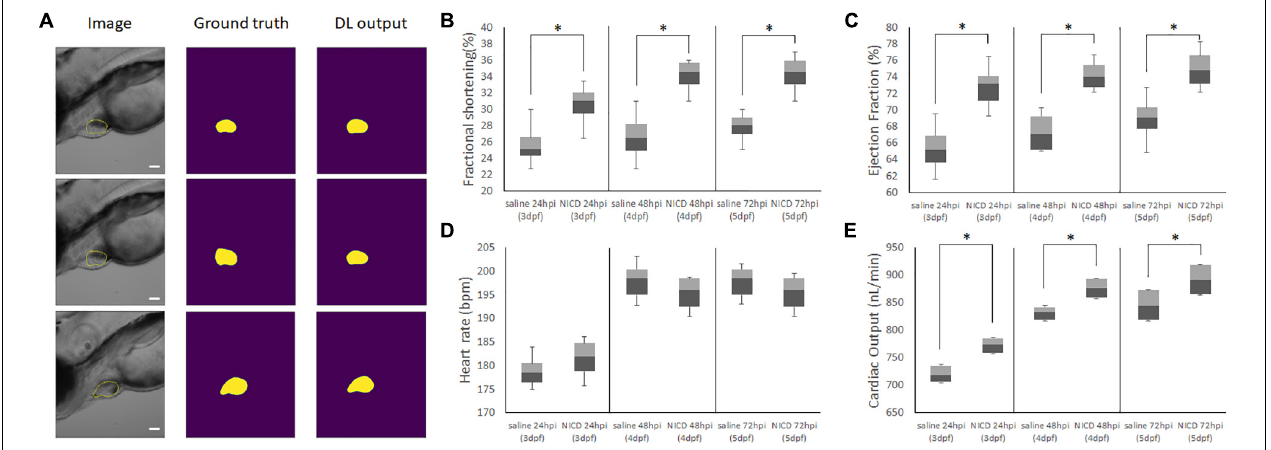
FIGURE 5 | Representative Images of Model Output for analyzing cardiac functions. (A) Representative images of the image input (column 1), hand segmented cardiac volume (column 2), and the model’s predicted cardiac volume after training the ZACAF network (column 3). (B,C) FS and EF comparisons demonstrated the zebrafish heart contracts stronger after injecting NICD incorporated PLGA nanoparticles. (D) Injection of NICD loaded PLGA nanoparticles didn’t affect heart rate. (E) Cardiac output of both control group and NICD loaded nanoparticles gradually increased as zebrafish heart matures. However, nanoparticles injected zebrafish has higher number of cardiac output. * indicates a significant difference ( p < 0.01). n = 250 zebrafish images per